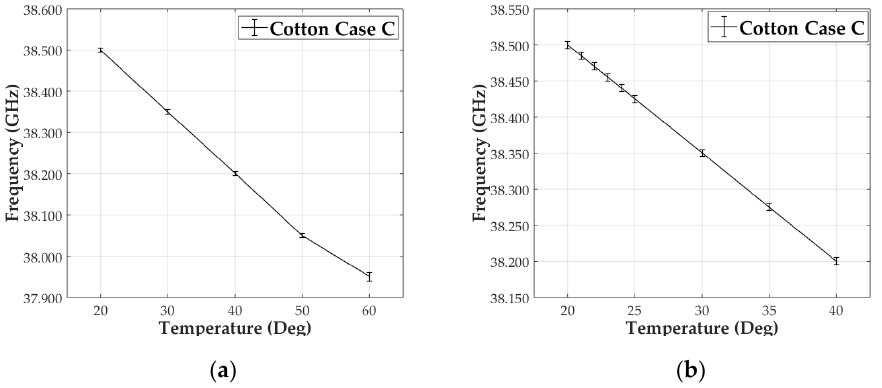
Figure 11. Measured frequency vs temperature representation. Cotton Case C at 38 GHz for: ( a ) 20–60 °C/10 °C steps and ( b ) 20–40 °C/5 °C steps and 20–24 °C/1°C steps. Table 4. Frequency shift over temperature sweep (measured results in MHz).